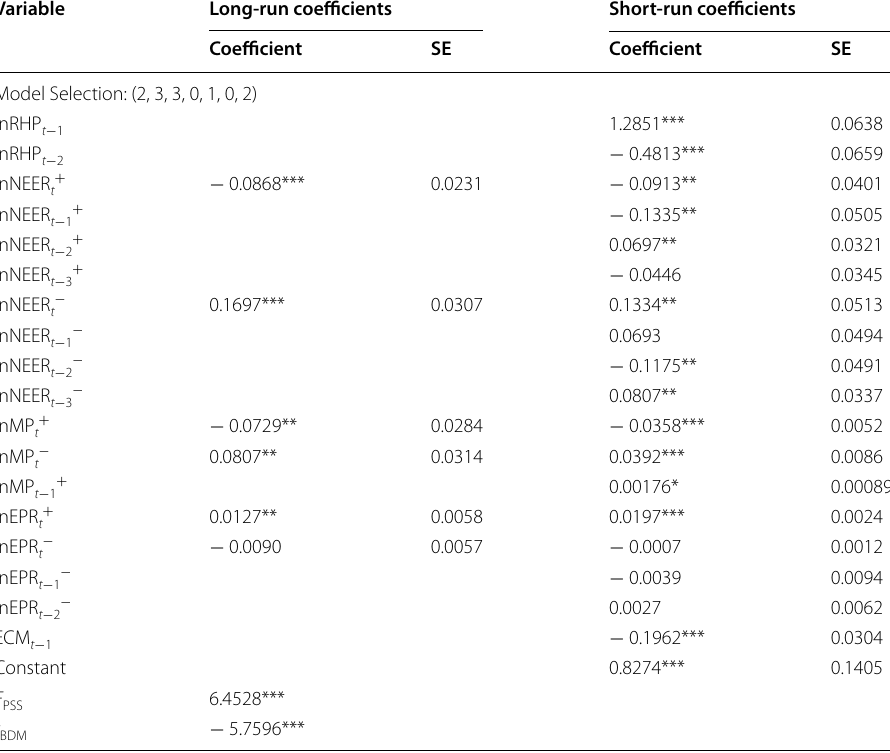
Superscripts *, **, and *** represent level of significance at 1%, 5%, and 10%. F PSS uses F‑statistic and t BDM uses a t‑statistic